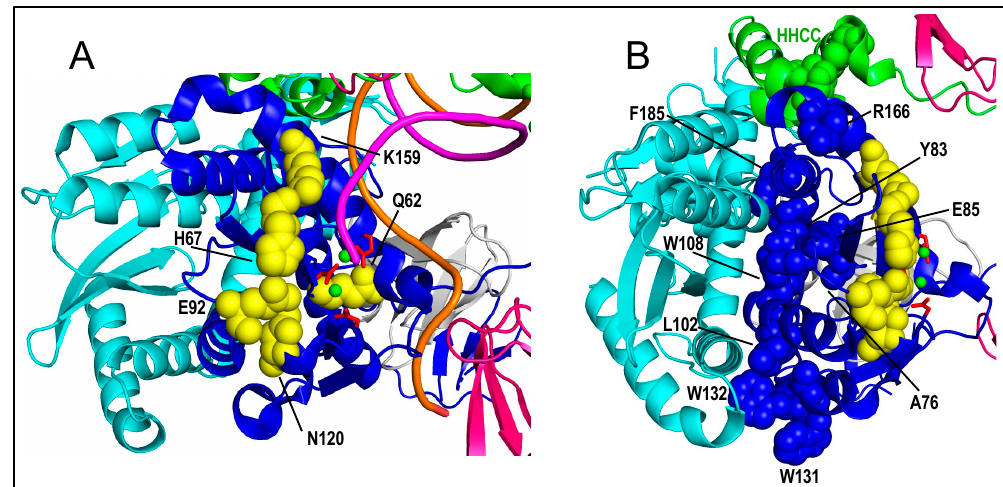
Figure 5. Class I and class II IN mutations and IN oligomerization interface proximity. ( A ) The blue CCD from the HIV-1 intasome in Figure 3 was resected and positioned to highlight active site proximal amino acid residues (in yellow space fill) that when changed yield the class I IN mutant viral phenotype. DDE active site residues are shown as red sticks. ( B ) The panel A image was rotated clockwise ~45° around the y-axis to highlight the cyan CCD-blue CCD dimerization interface. Blue CCD and green NTD amino acid residues that when mutated yield the class IIc IN mutant viral phenotype (see Table 1, below) are shown in space fill [51,56,122,124,148–150]; His12, His16, and Cys40 are collectively labeled HHCC. The panel B image highlights oligomerization interface proximity of residues that when changed yield class II IN mutant viruses. For clarity, the DNA duplex was omitted from panel B. Table 1. Phenotypic classes of HIV-1 IN mutant viruses.